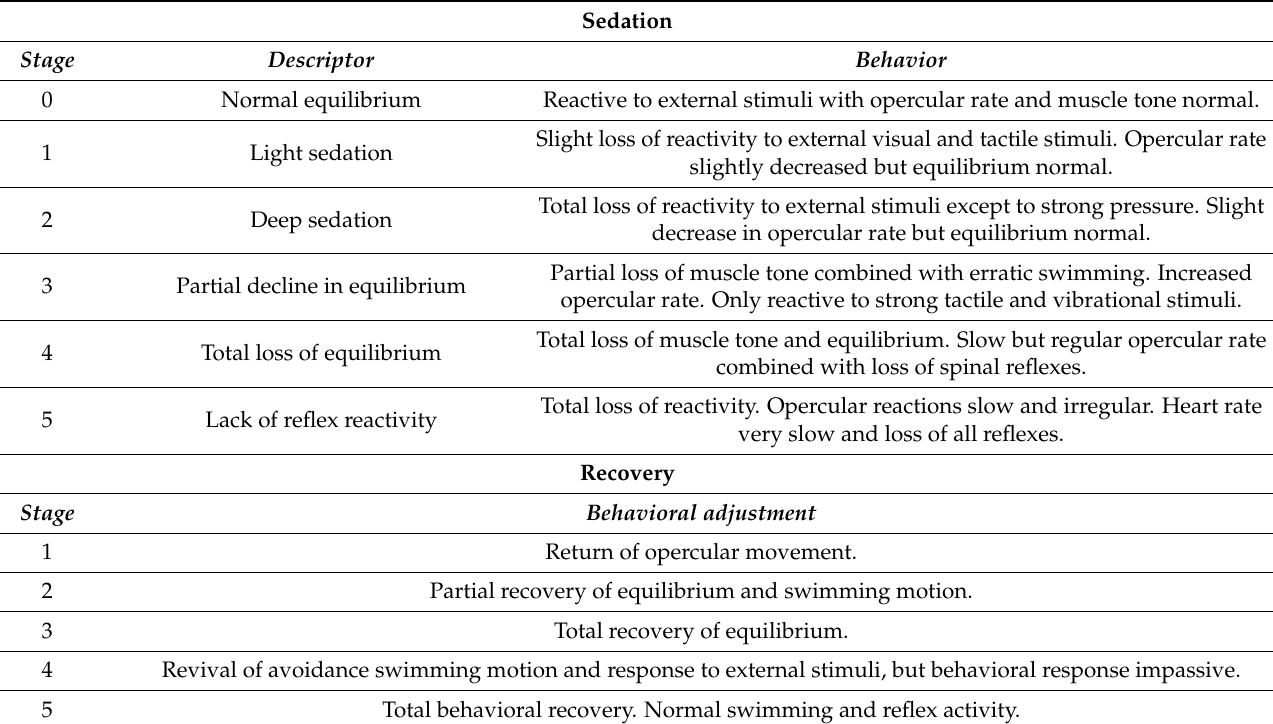
Table 1. Behavioral alterations of cobia to various stages of anesthesia and recovery therefrom, modified from Keene et al.